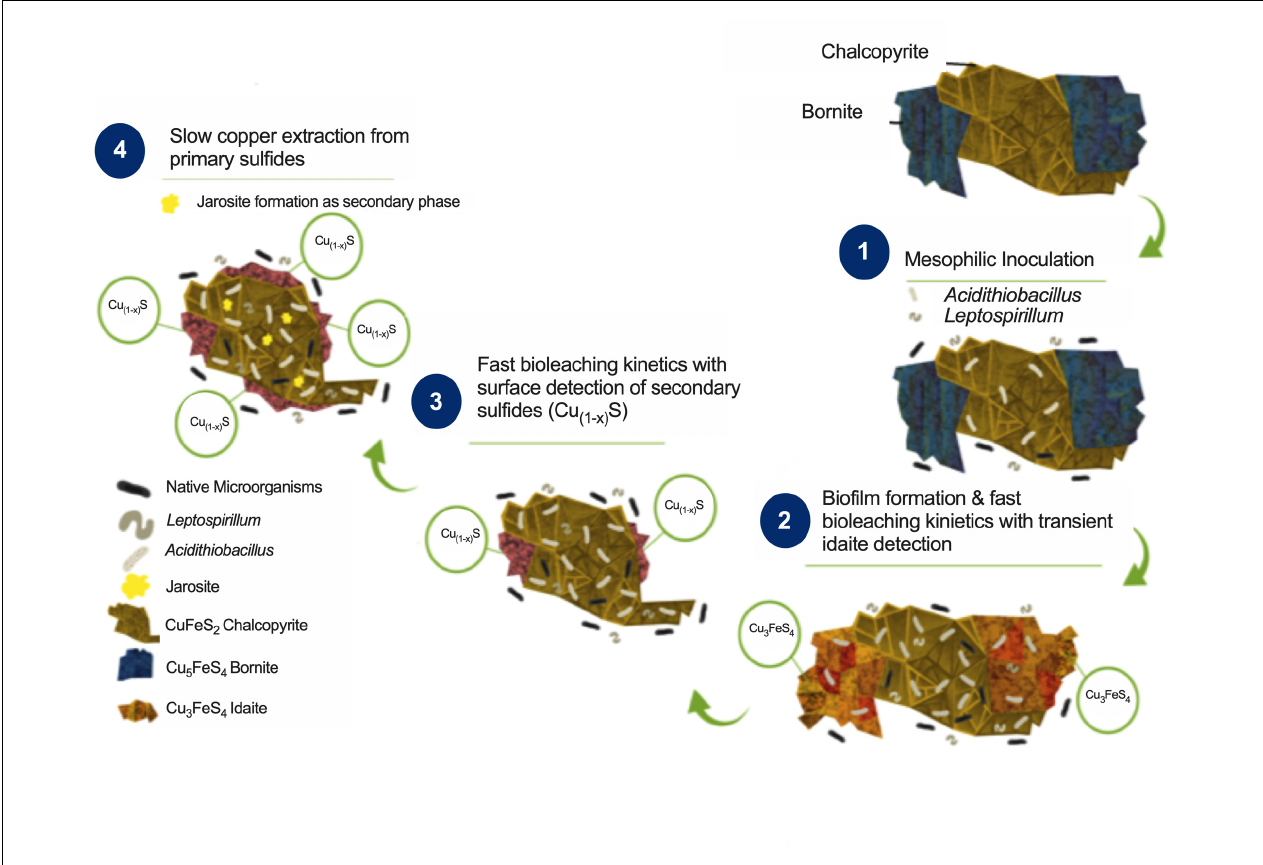
FIGURE 6 | Proposed bioleaching mechanism for primary copper sulfides bornite and chalcopyrite under mesophilic inoculation of bacteria with iron- and sulfur-oxidizing activity forming